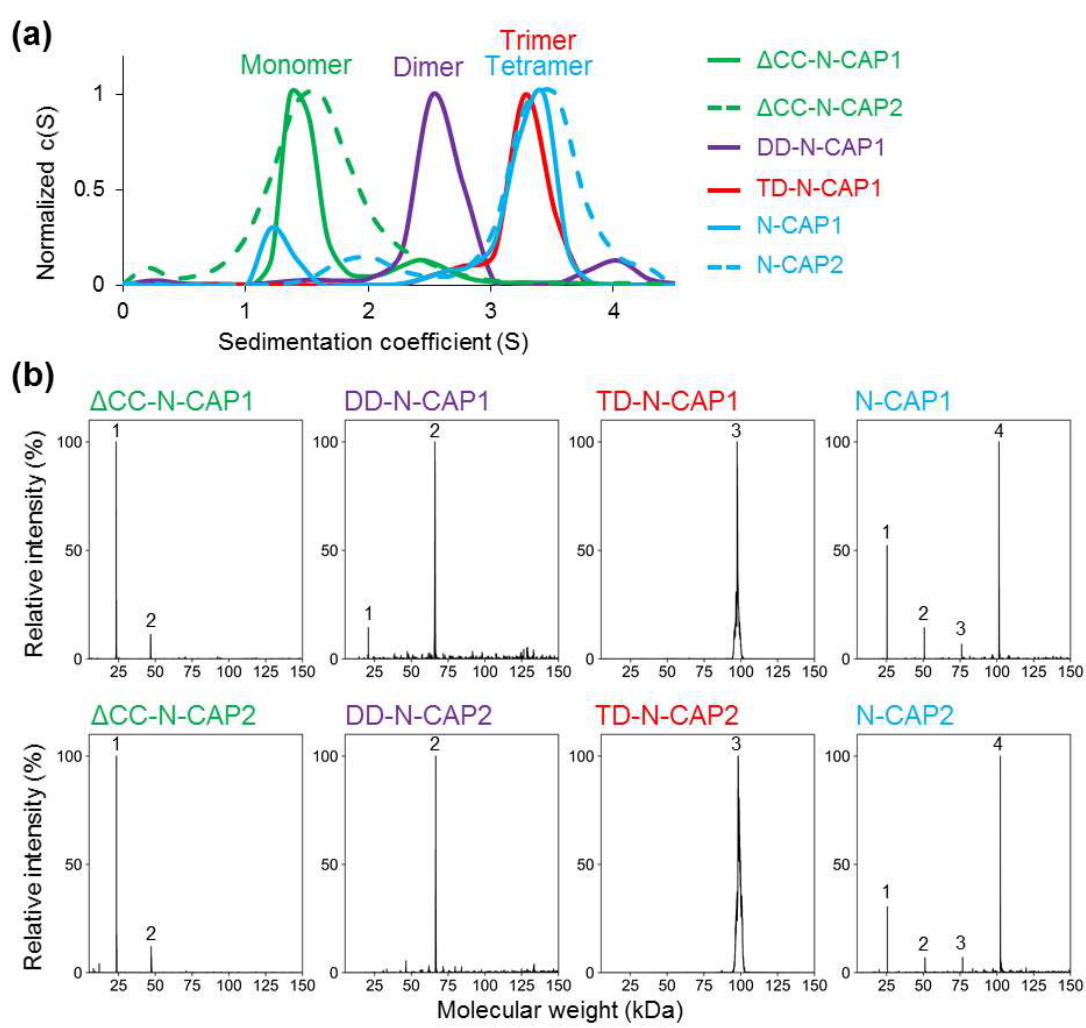
Figure 2. Oligomerization state of the N-terminal constructs of human CAPs: ( a ) sedimentation velocity analytical ultracentrifugation (SV-AUC) data were analyzed using SEDFIT software with a continuous sedimentation coefficient distribution model c(S). ( b ) Raw m/z data obtained by native mass spectrometry (MS) were deconvoluted with UniDec 4.0 and the molecular weights of the constructs were calculated. Numbers in the graphs indicate the oligomeric state of the CAP constructs present in solution: 1—monomer, 2—dimer, 3—trimer, 4—tetramer.